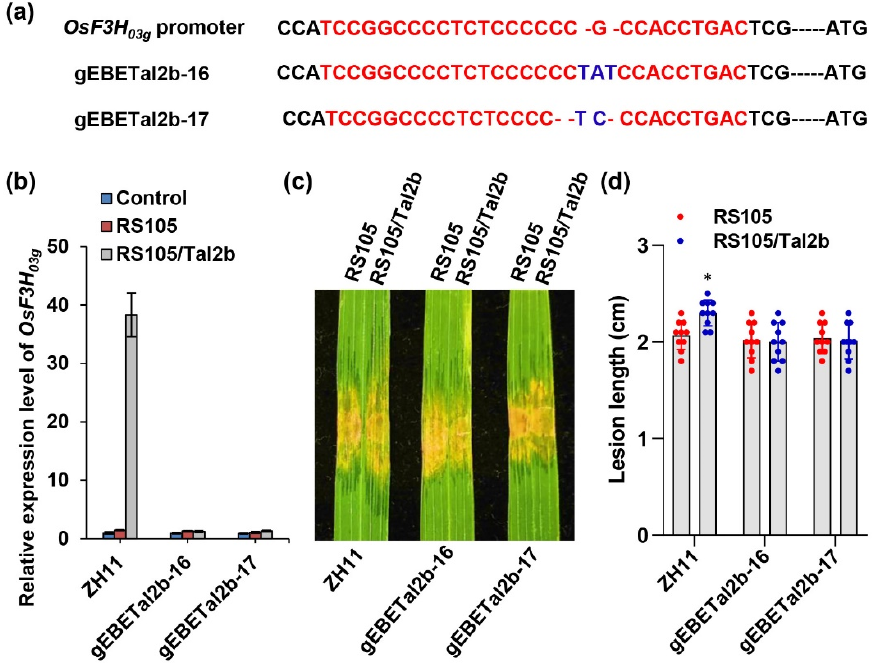
Figure 4. Gene editing of EBE in the OsF3H 03g promoter reduces rice susceptibility to Xoc strain RS105/Tal2b. ( a ) Genotypes of the EBE gene editing lines (gEBETal2b-16 and gEBETal2b-17) in the OsF3H 03g promoter. The sequences in red represent the Tal2b binding sites, and the bases in blue represent the substitution in the OsF3H 03g promoter. ( b ) Relative expression level of OsF3H 03g in the ZH11, gEBETal2b-16 and gEBETal2b-17 lines at 4 dpi with RS105 and RS105/Tal2b. OsACTIN was used as an internal control. Data represent the means ± SD, n = 3. ( c ) Photograph of lesion expansion and ( d ) diagram of lesion length in the ZH11, gEBETal2b-16 and gEBETal2b-17 lines at 14 dpi with RS105 and RS105/Tal2b. Data represent the means ± SD, n = 10. Asterisks represent significant differences between RS105 and RS105/Tal2b in ZH11 rice (* p ≤ 0.05, Student’s t -test).